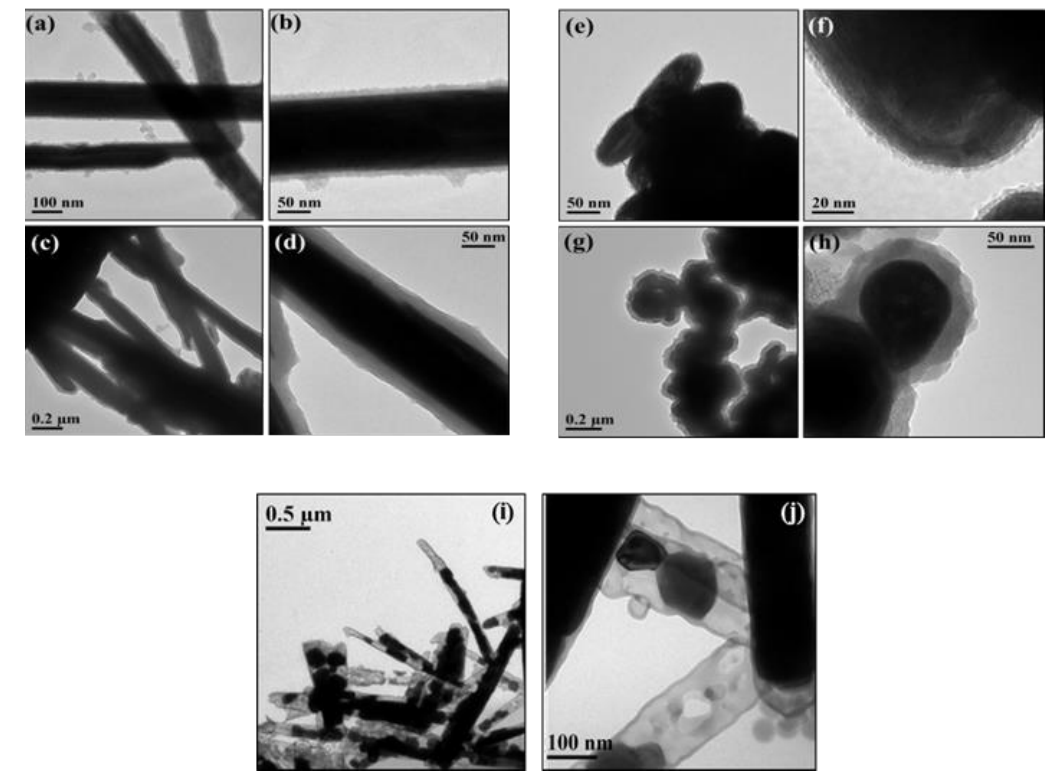
Figure 1. Transmission Electron Microscopy (TEM) images of WS 2 @SiO 2 nanocomposites: INT-SiO 2 -1P ( a , b ); INT-SiO 2 -5P ( c , d ); IF-SiO 2 -1P ( e , f ); IF-SiO 2 -5P ( g , h ) and INT-SiO 2 -1P after heating at 600 ◦ C